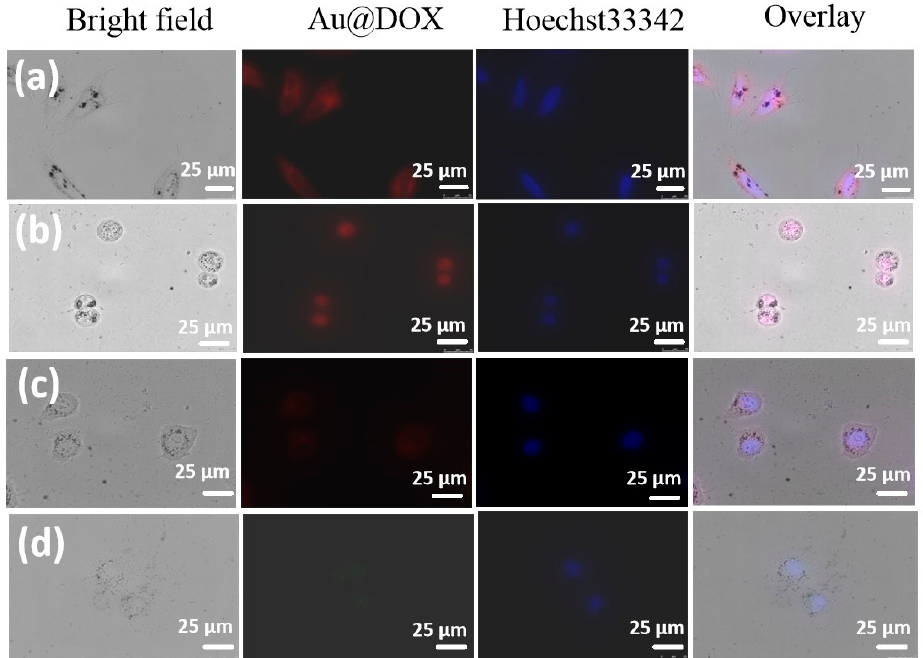
Figure 5. Distribution in different cell types in response to the treatment with Au@MPA-PEG-HA- ADH-Dox. ( a ) HepG2 cells; ( b ) HCT-116 cells; ( c ) SMMC-7721 cells; ( d ) Hela cells. Scale bar = 25 μ m.